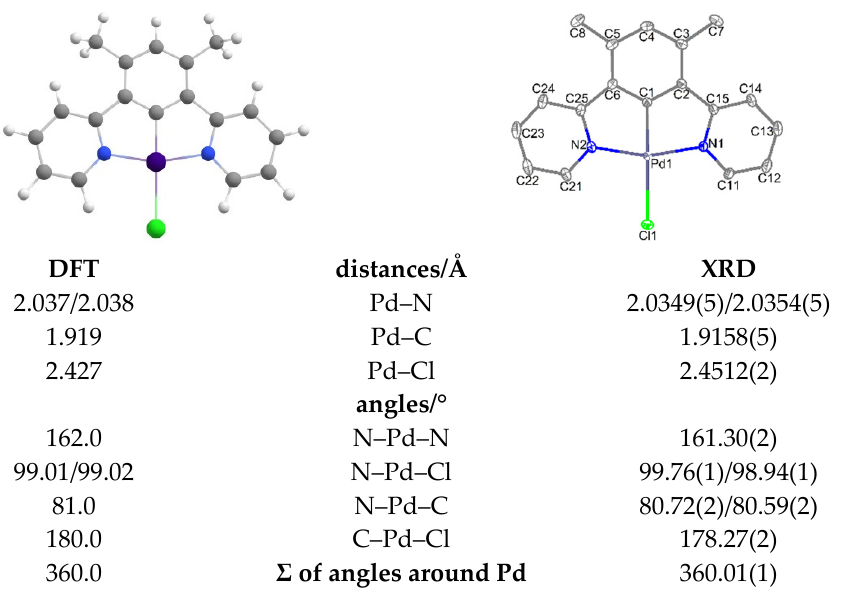
Figure 1. DFT-calculated molecular structure of [Pd(Me 2 dpb)Cl] (left) and experimental structure from single crystal X-ray diffraction (ORTEP plot with displacement ellipsoids at 50% probability, right) (Table S3).